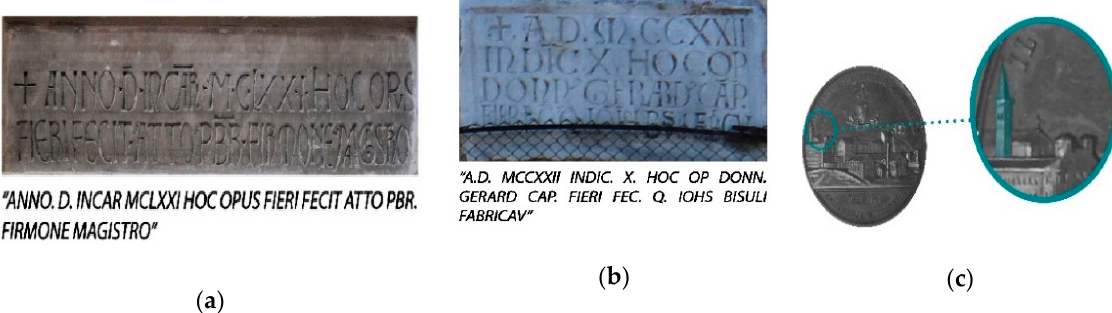
Figure 2. ( a ) Walled inscription inside the Church; ( b ) inscription placed above the rose window; and ( c ) commemorative coin depicting the roof of the bell tower.